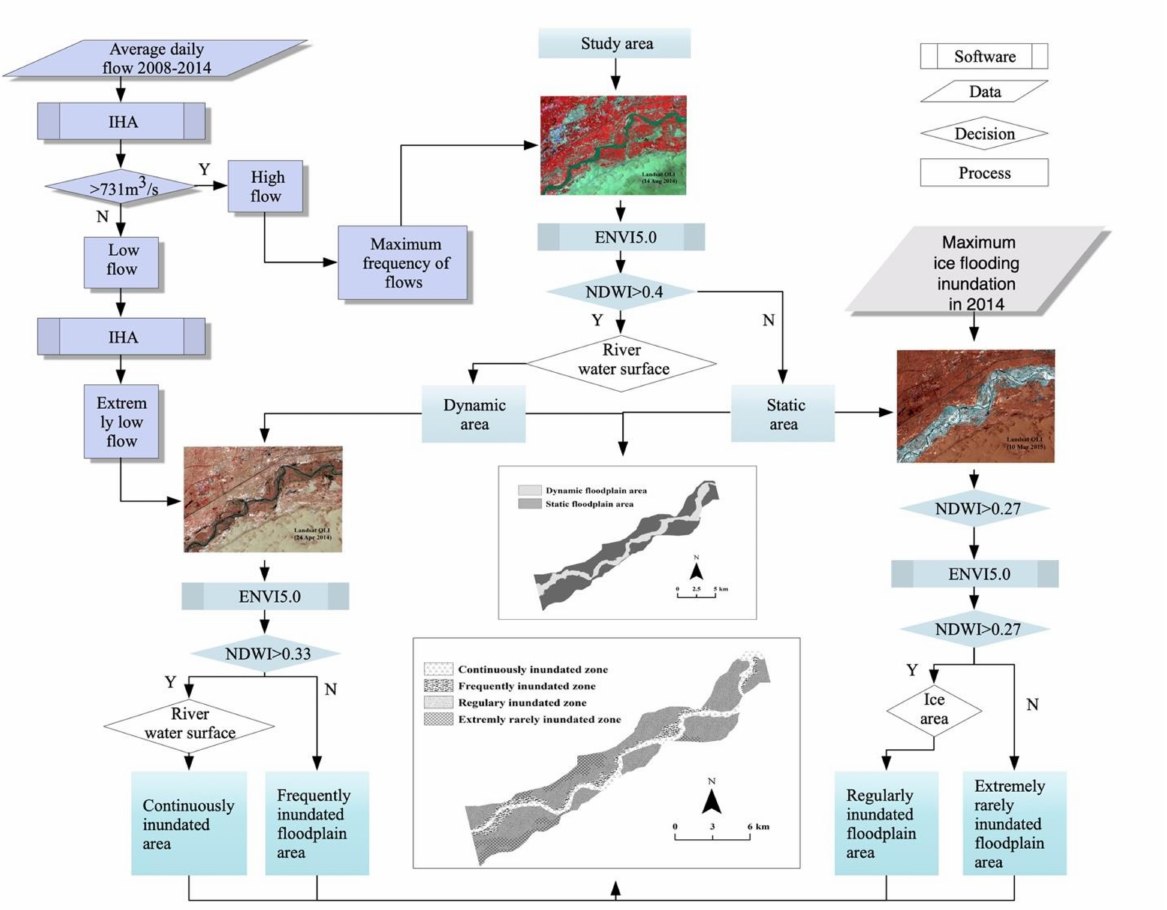
Figure 2. Workflow determining the four floodplain zones and the areas corresponding to different levels of hydro- geomorphological activity based on the floodplain hydro-geomorphology in the study years. The purple colour represents the process of the river hydrology, the light blue colour represents the zonal division process of the study area, dark blue represents the final